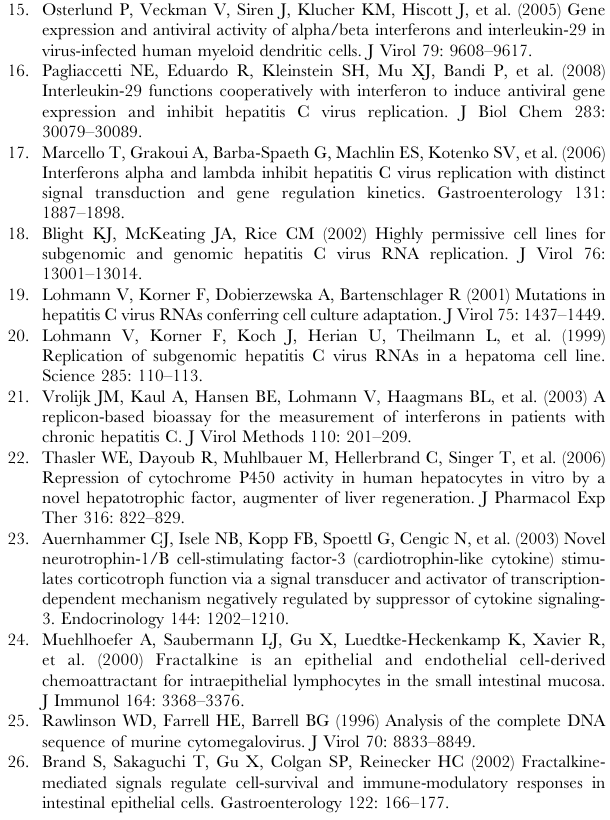
Figure S2 Functional categorization of IL-28A repressed gene expression. (A) In IL-28A-treated samples, the down- regulated genes are enriched in the biological process of mRNA transcription regulation (for color chart legend, see Figure S1A). IL-29 did not down-regulate genes significantly (data not shown). (B) The molecular functions of IL-28A down-regulated genes comprise mainly of nucleic acid binding proteins and of homeobox transcription factors (for color chart legend, see Figure S1B).